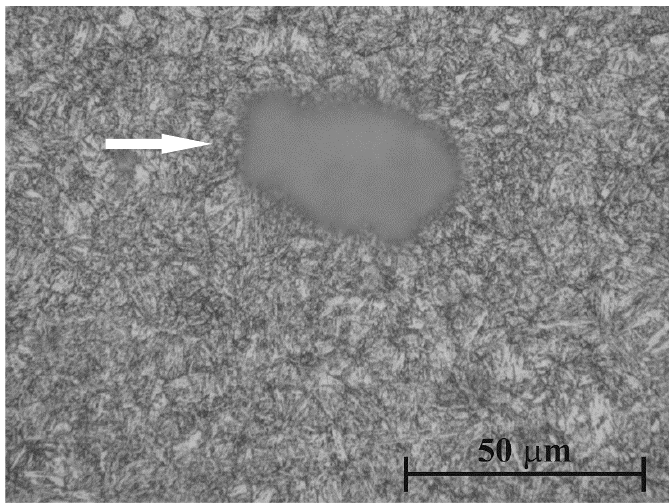
Figure 1. Microstructure of the DIN 34CrNiMo6 high-strength steel from a sample polished and etched with nital (optical microscopy).